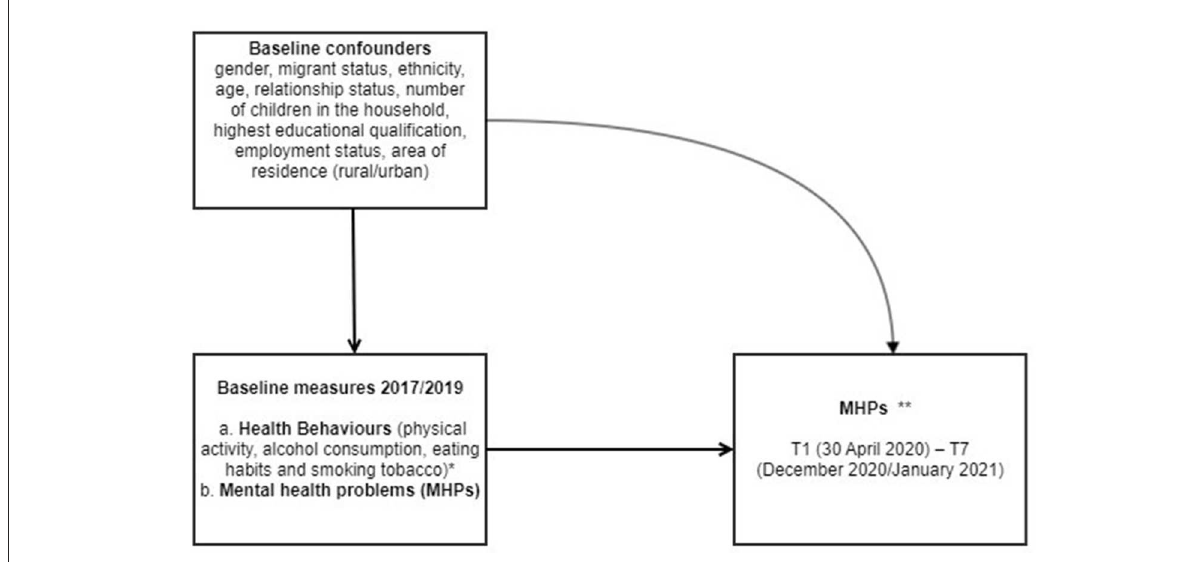
FIGURE1 Directed acyclic graph for the current study. *Health behaviours assessed with 16 items capturing the frequency and/or intensity of the four behaviours mentioned. **Mental health Problems (MHPs) was measured at multiple time points throughout the pandemic: wave 1 (30